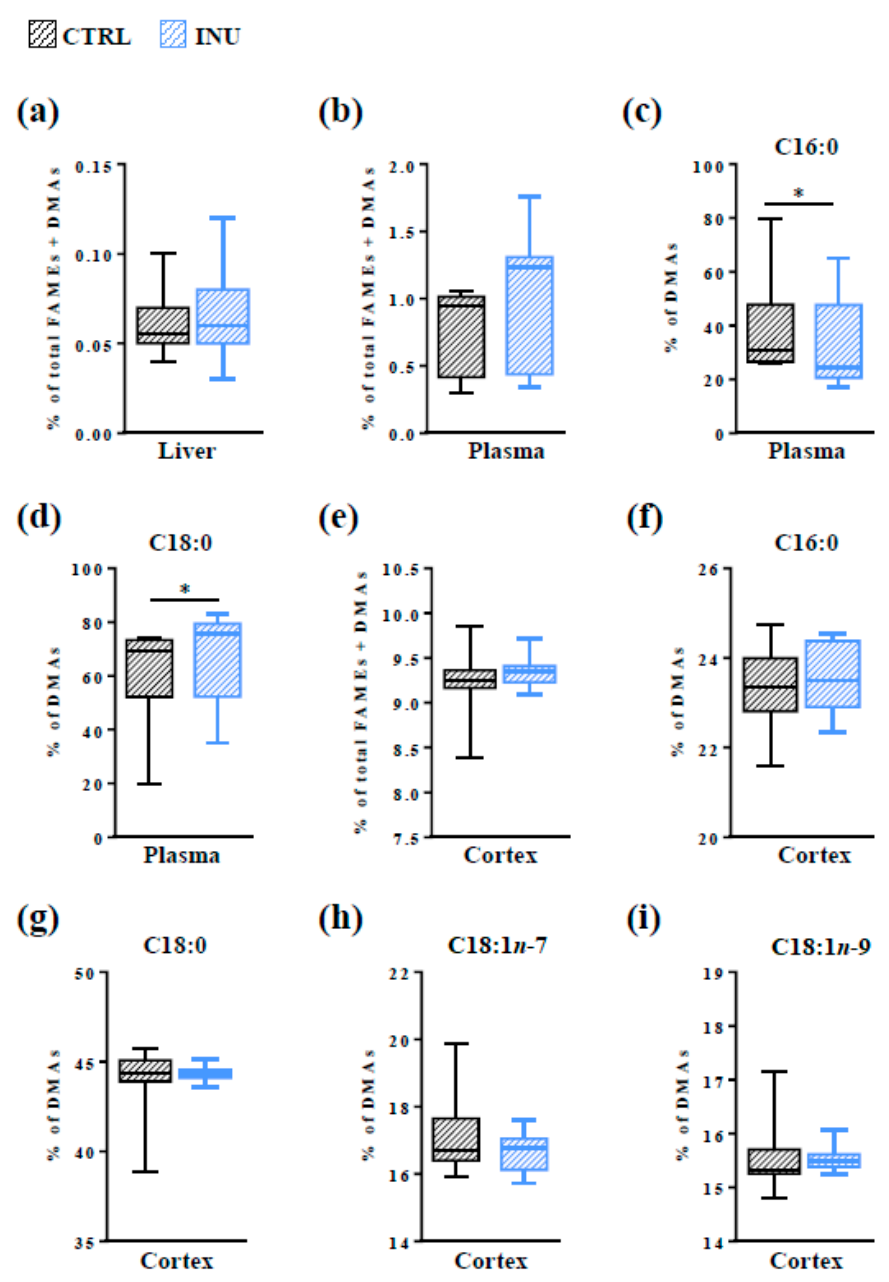
Figure 2. Evaluation of plasmalogen (Pl) content in the liver, plasma and cortex by GC-FID. The results represent the quantification of dimethylacetals (DMAs, derivatives of aldehyde aliphatic groups from the sn -1 position of Pls) by GC-FID. ( a , b , e ) Results are expressed as percentages of total DMAs relative to total fatty acid methyl esters (FAMEs) + total DMAs, defined as 100%, in the liver ( a ), in the plasma ( b ) and in the cortex ( e ). ( c , d , f – i ) percentages of ( c , f ) DMA 16:0, ( d , g ) DMA 18:0, ( h ) DMA 18:1 n -7, and ( i ) DMA 18:1 n -9 relative to total DMAs (defined as 100%), in the plasma ( c , d ) and in the cortex ( f – i ). CTRL: mice fed a control diet. INU: mice fed a diet supplemented with inulin. Data are presented in box and whisker plot format (median; min. to max.). Mann–Whitney test for comparison of lipid abundance between CTRL and INU mice, * p < 0.05. GC-FID, gas chromatography with flame-ionization